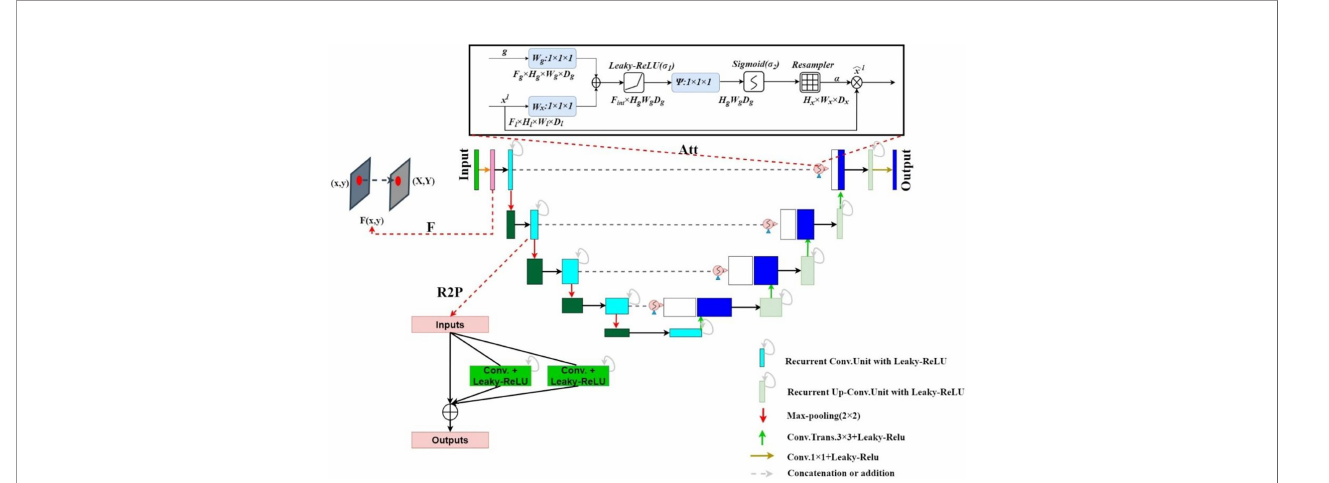
FIGURE 1 | FR2PAttU-Net